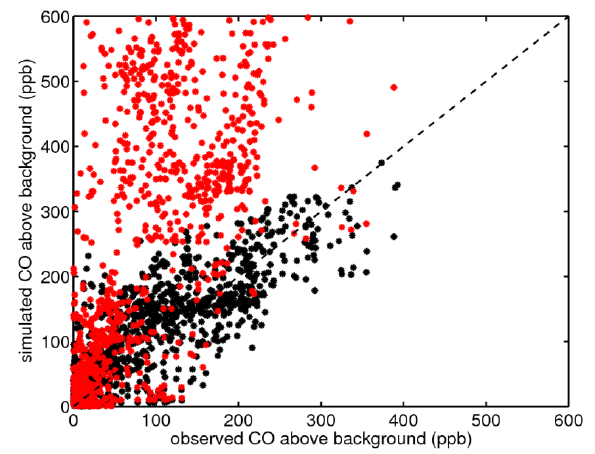
Fig. 2. Scatter plots of observed and simulated CO mixing ratio above background using the NEI 2005 inventory (red dots) or the CO posterior from the inversion (black dots) based on the ensemble of the three transport models for the three flights during weekdays. The dash line represents the one-to-one line shown for reference.